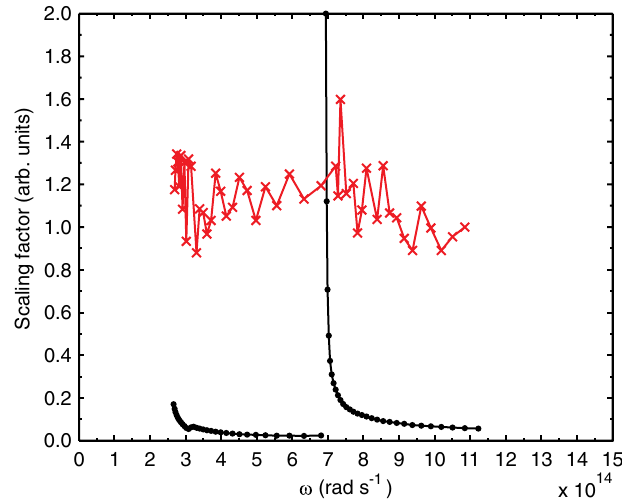
FIG. 7. Contributions to the relative pyroelectric detector cali- bration due to (a) grating reflectivity and dispersion (black dots); and (b) pyroelectric detector response (red crosses). The cali- bration factors plotted represent the inverse of system/detector sensitivity. Each data point represents a single pyroelectric detector. The significant variation between individual detector responses illustrates the need for reliable